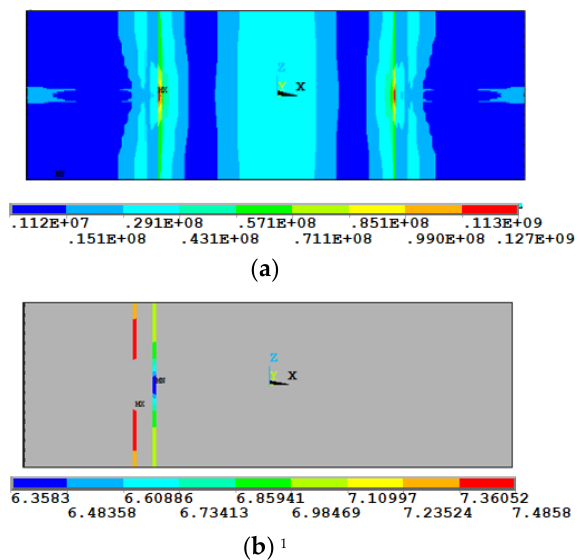
Figure 20. Mises stress distribution and cyclic life distribution of the deck plate. ( a ) Distribution contour of the Mises stress at the bottom side of the bridge deck (Pa). ( b ) Distribution of the fatigue cyclic life of the rib-to-deck connection, 1 the number in the contours is the base 10 log of the contour line.